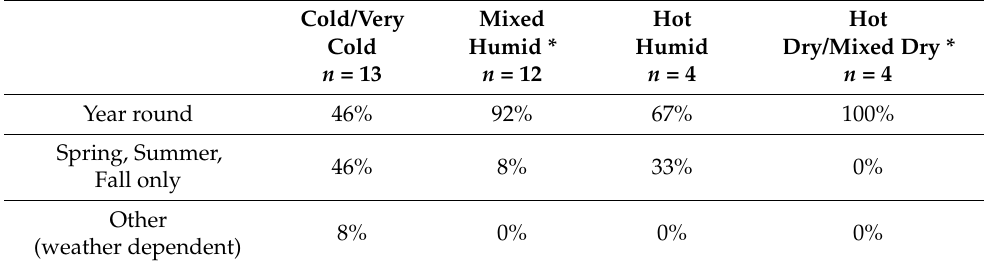
Table 2. Seasonality of Equine Assisted Services offered by climate designation.